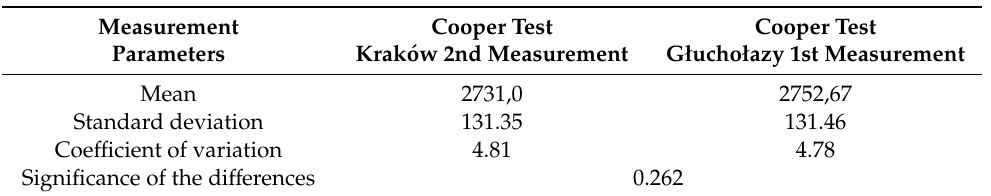
Table 3. The values of the stamina and performance parameters of the football players in the 2nd measurement in Krak ó w and the 1st measurement in Głuchołazy.